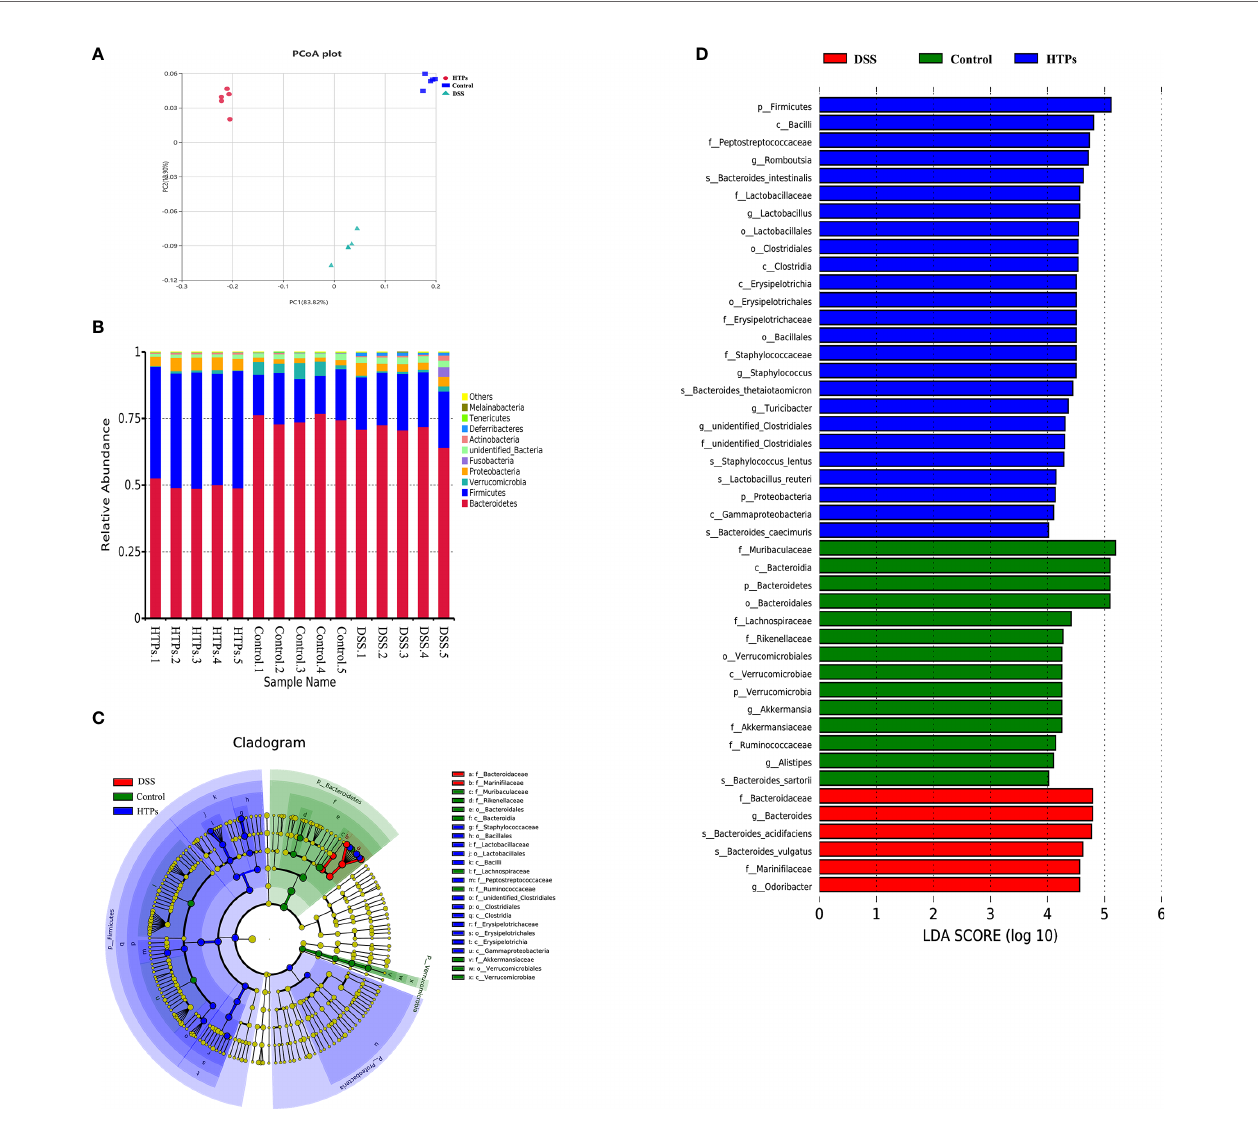
FIGURE 6 | (A) Beta diversity parameters measured with PCoA plot. Each point designates an individual sample, and the points of different colors represent various treatments. The distance between different points demonstrates the similarity or differences of the microbial community structure. (B) Microbial composition at phylum levels in HTPs, control and DSS groups. Linear discriminant analysis effect size (LEfSe) analysis of microbiota in HTPs, control and DSS groups: (C) taxonomic cladogram demonstrating highly abundant taxa across various treatments. (D) taxa that meet an LDA score threshold of > 4 ( n =